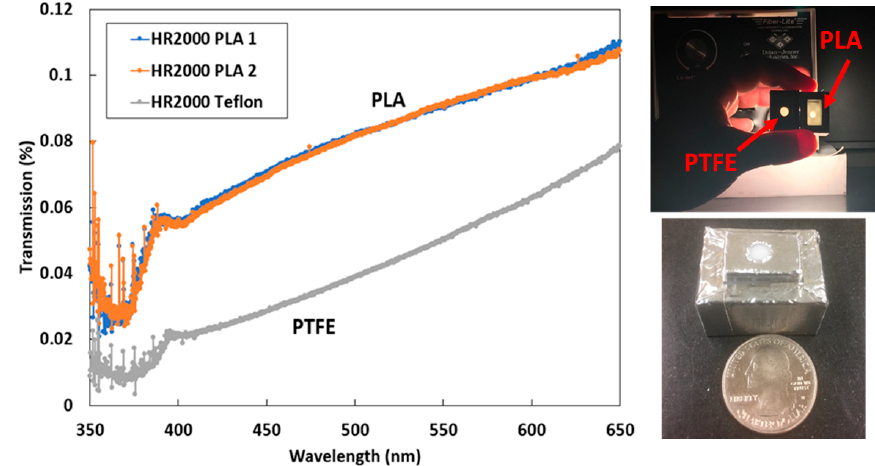
Figure 3. Transmissivity of polylactic acid (PLA) and Teflon diffusers using Ocean Optics